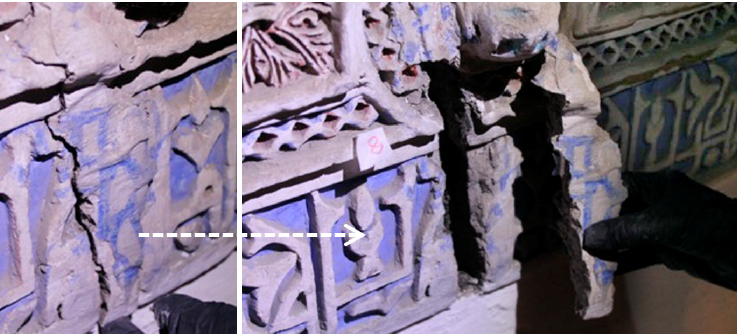
Figure 4. The plaster addition removed during the visual inspection in the Toledanos room.